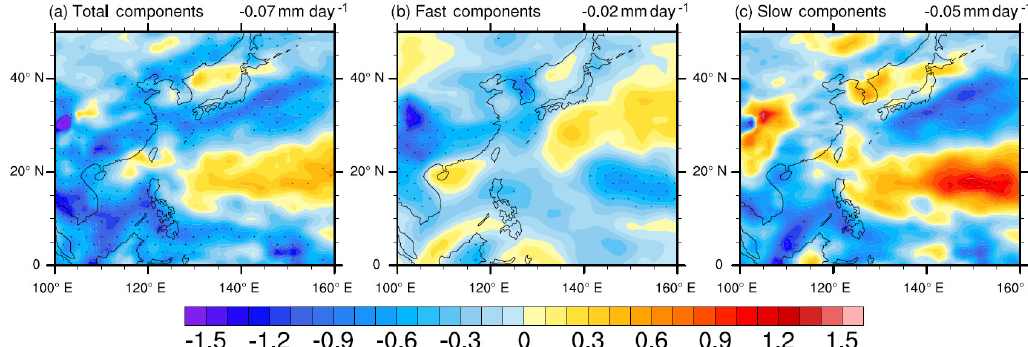
Figure 8. JJA mean total, fast, and slow responses of precipitation rate to SO 4 forcing (unit: mmday − 1 ) . The values in the top right corner of the figures represent the responses averaged over the region 0–50 ◦ N, 100–140 ◦ E. The dots represent significance at ≥ 95% confidence level from the t